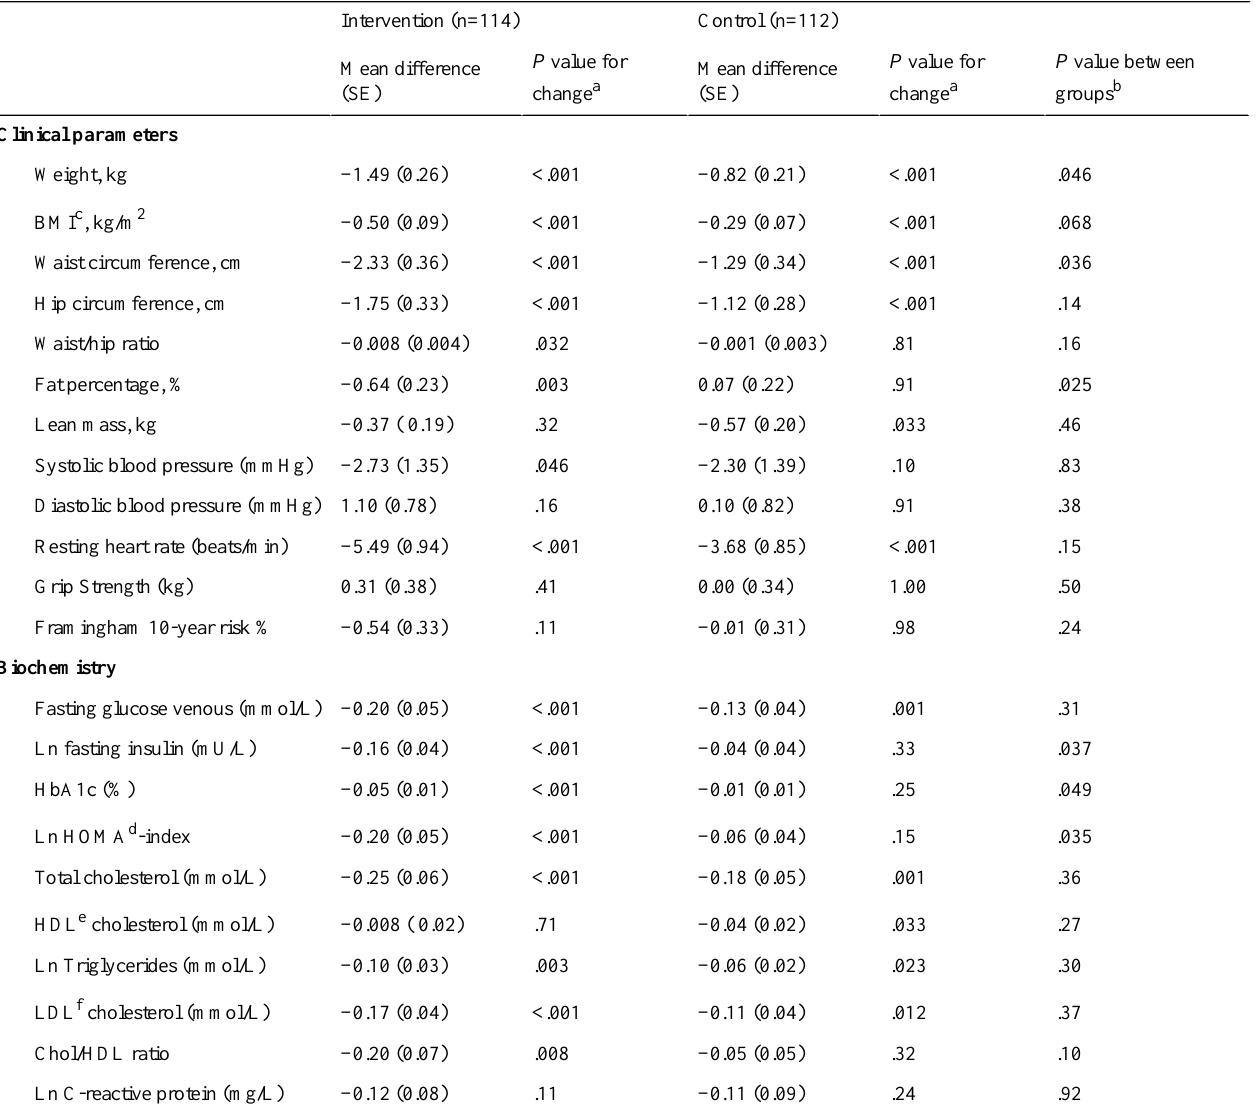
Table 2. Changes in parameters of metabolic health in study participants at follow-up (data represent mean differences with standard error